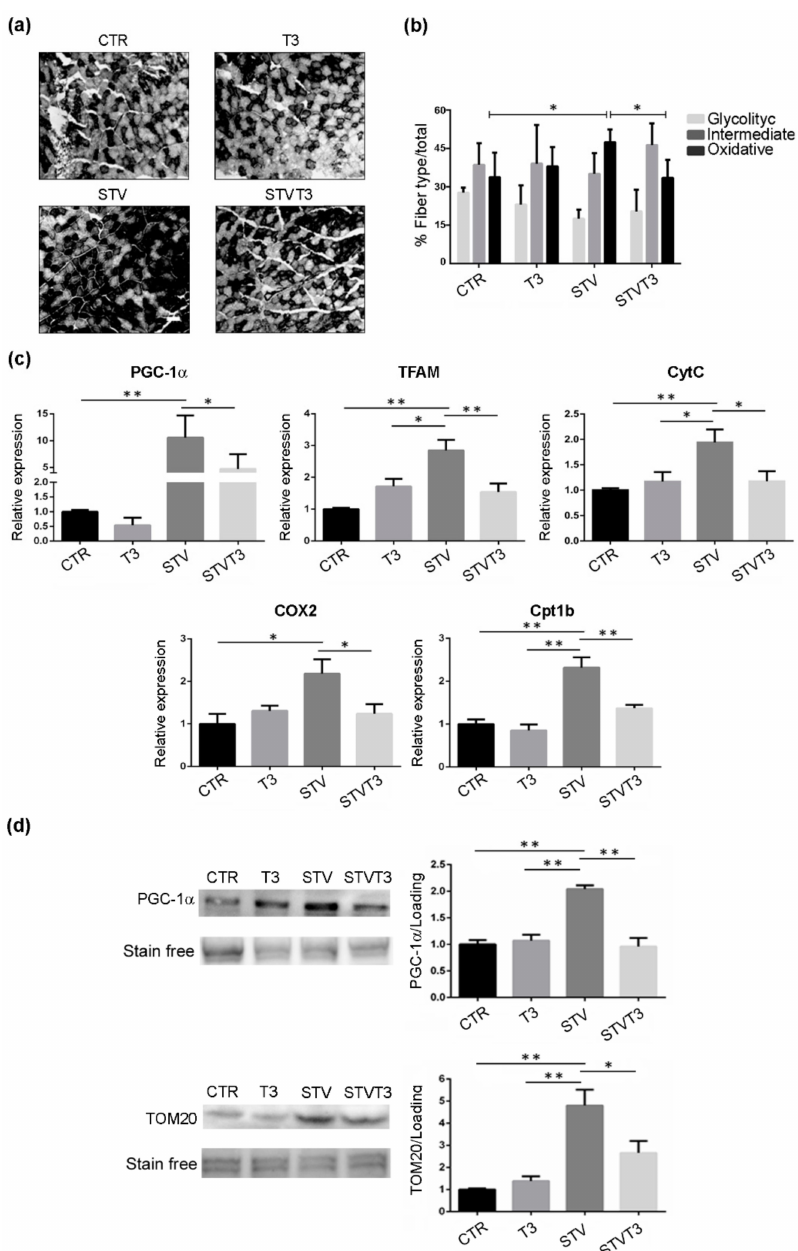
Figure 6. T3 modulates skeletal muscle metabolism following starvation. ( a ) Representative pictures of TA muscles stained with NADH, 48 h after treatments. Scale bar = 20 µ m. ( b ) Quantification of oxidative, intermediate, and glycolytic myofibers, relative to total fibers, 48 h after treatments. n = 4 mice per each condition. Data are presented as means ± SD. Only for oxidative fibers: STV and T3 significantly interact ( p = 0.009) by two-way ANOVA; * p < 0.05 with post hoc Tukey’s HSD test. ( c ) Expression levels of indicated genes by real-time PCR, 24 h after treatments. n = 6 mice per each condition. Data are presented as means ± SD. For PGC-1 α : STV and T3 significantly interact ( p = 0.039) by two-way ANOVA, * p < 0.05 and ** p < 0.01 with post hoc Tukey’s HSD test; for TFAM: STV has a significant e ff ect ( p < 0.0001), STV and T3 significantly interact ( p < 0.0001), * p < 0.05 and ** p <